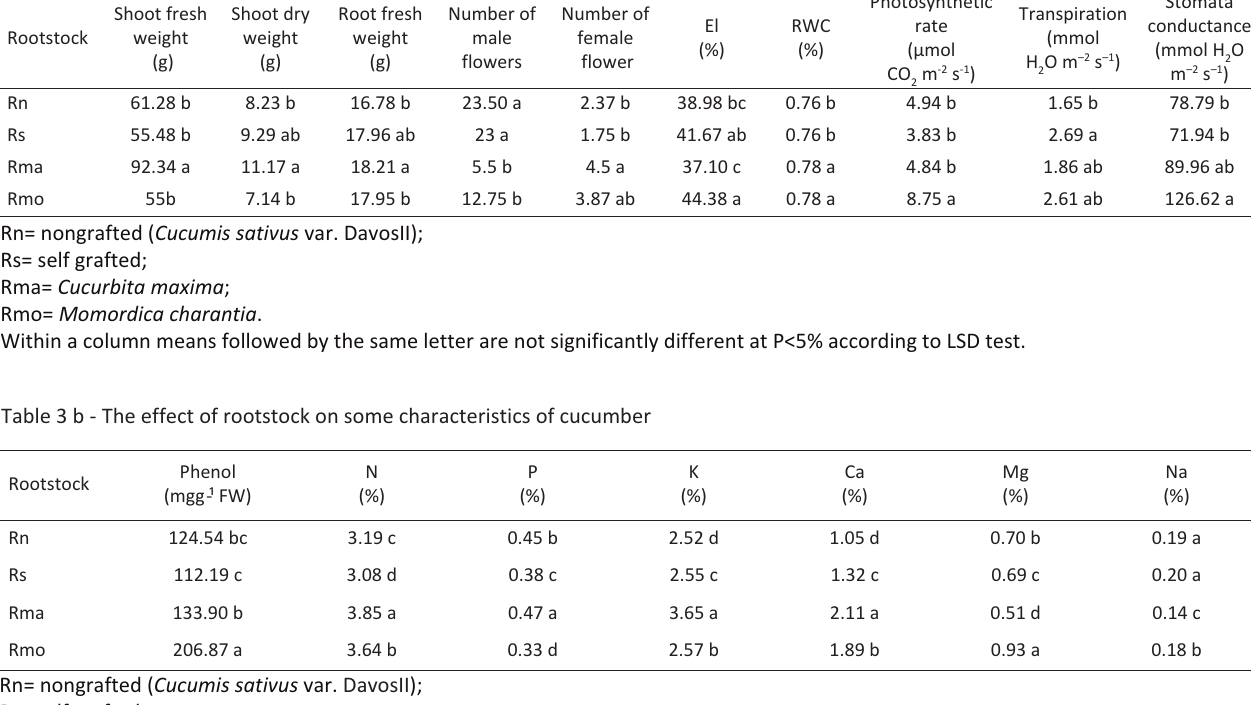
Table 3 a ­The effect of rootstock on some characteristics of cucumber